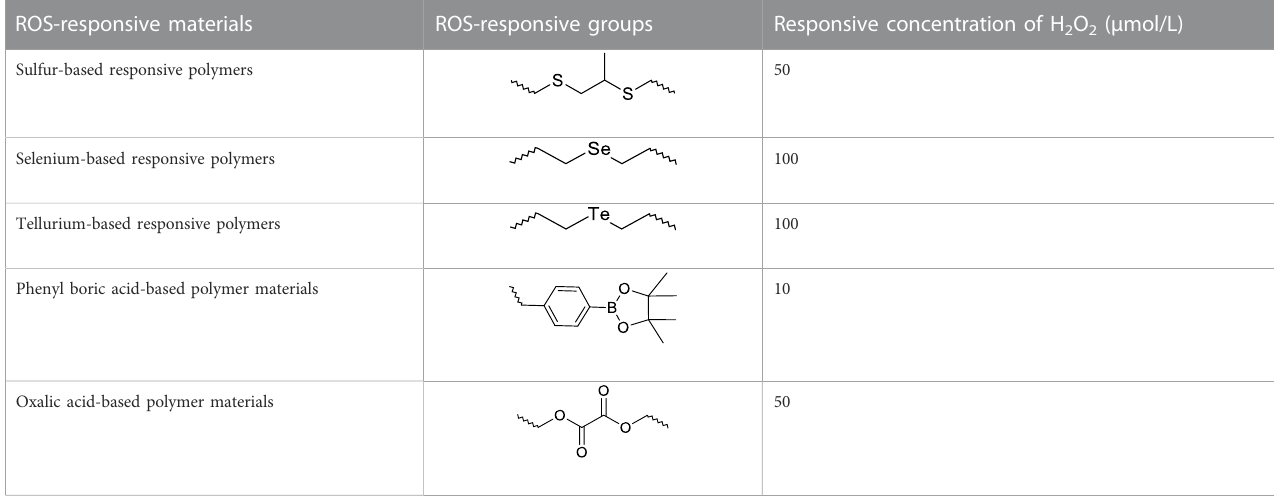
TABLE 1 Common ROS-responsive groups.